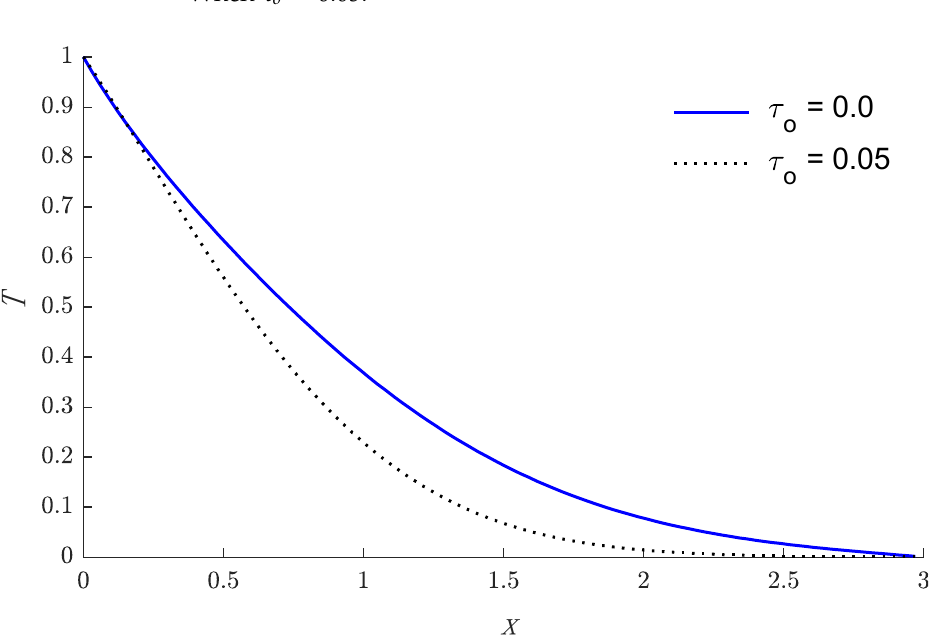
Figure 6. The temperature distributions via the distance 𝑥 with and without thermal relaxation time. When 𝛼 = 0.1 :